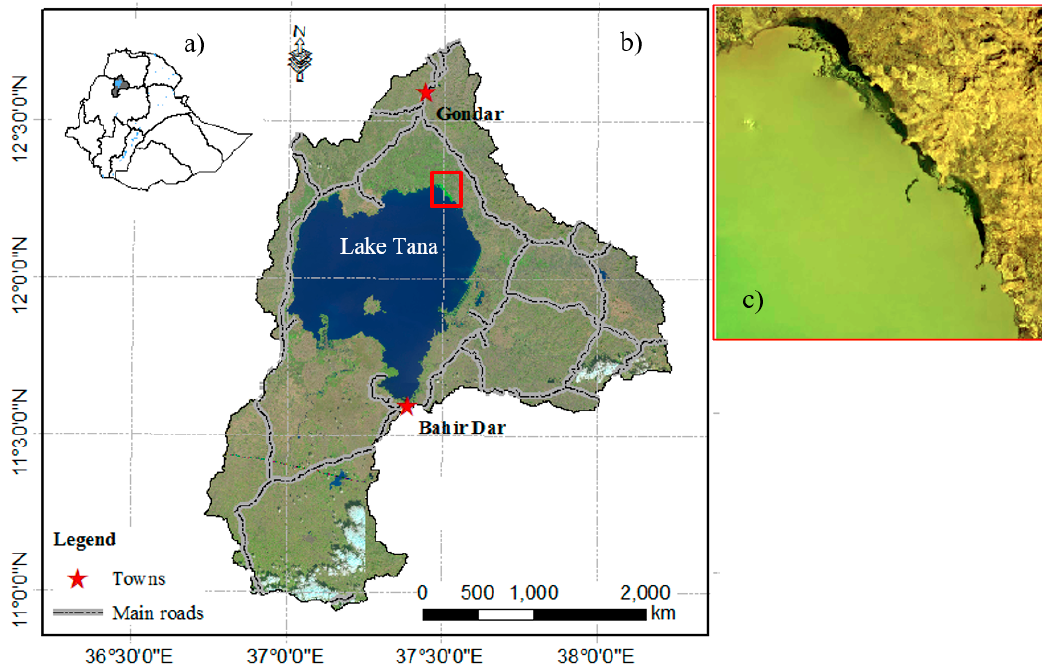
Figure 1. Study area location. ( a ) The left insert is the Ethiopian map with its major river basins; the dark color represents the location of Lake Tana catchment. ( b ) A true-color composite of Sentinel-2 satellite image taken on November 28, 2017 ( c ) Extent of water hyacinth in the northeast shore of Lake Tana (PlanetScope image, January 20, 2018).